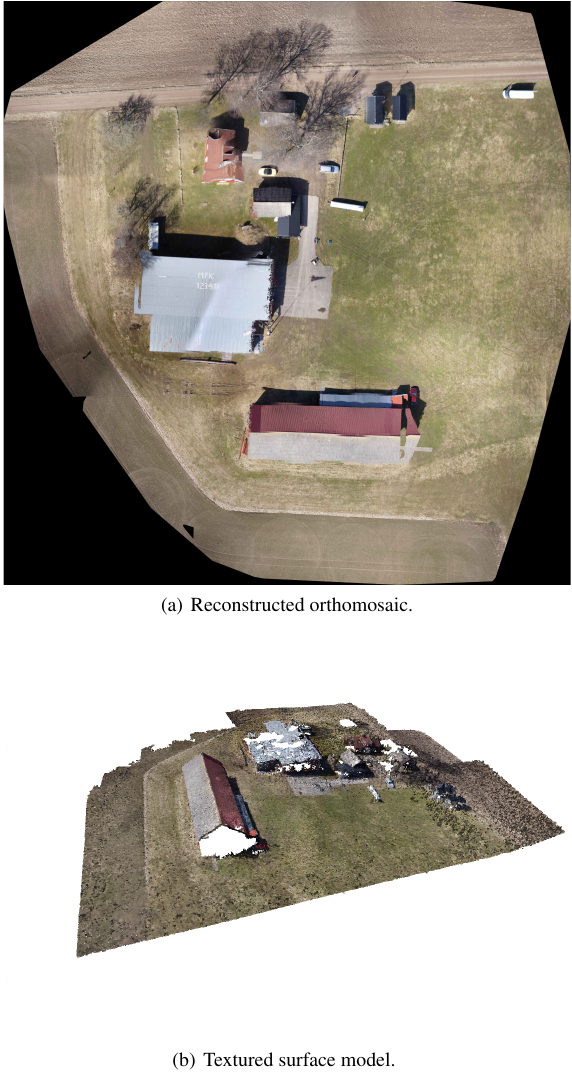
Figure 4: Orthomosaic and textured surface model of the airfield in Motala (Sweden) object of the reconstruction analysis. The orthomosaic and the surface model are generated with the pho- togrammetric software Pix4UAV .